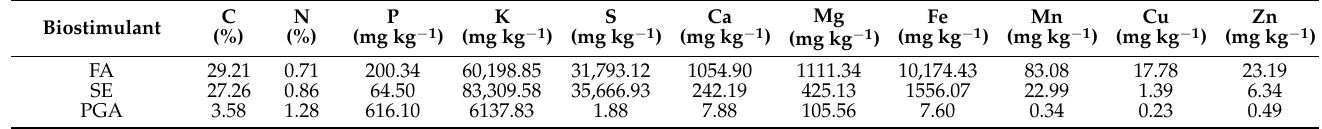
Table 1. Nutrient concentration in evaluated biostimulants.